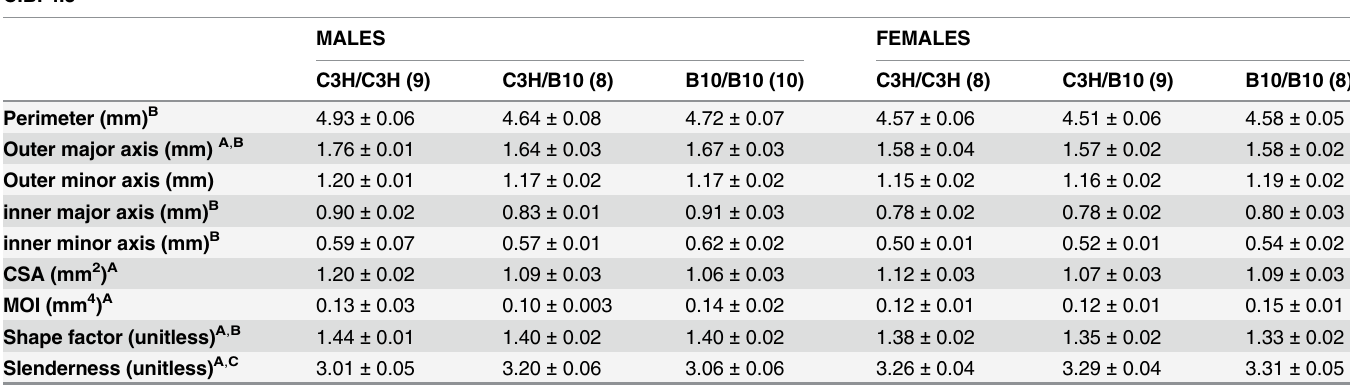
Table 2. Femoral Geometry of C.B.4.3